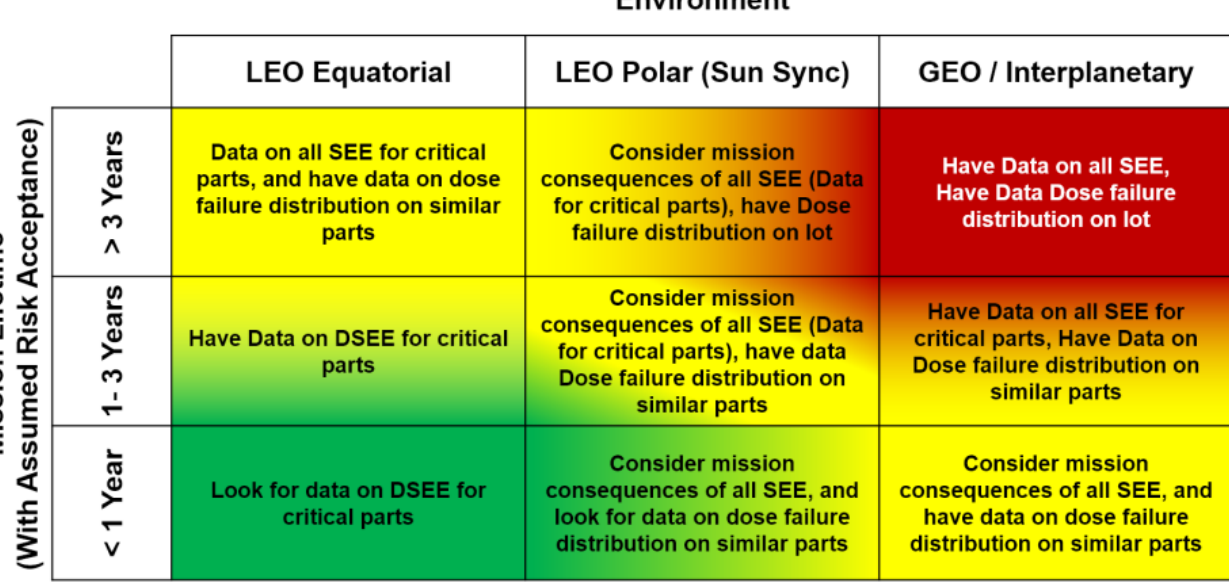
Figure 5. Radiation data required for quantifying risk in a represented mission and different mission durations. Reprinted from ref. [10].